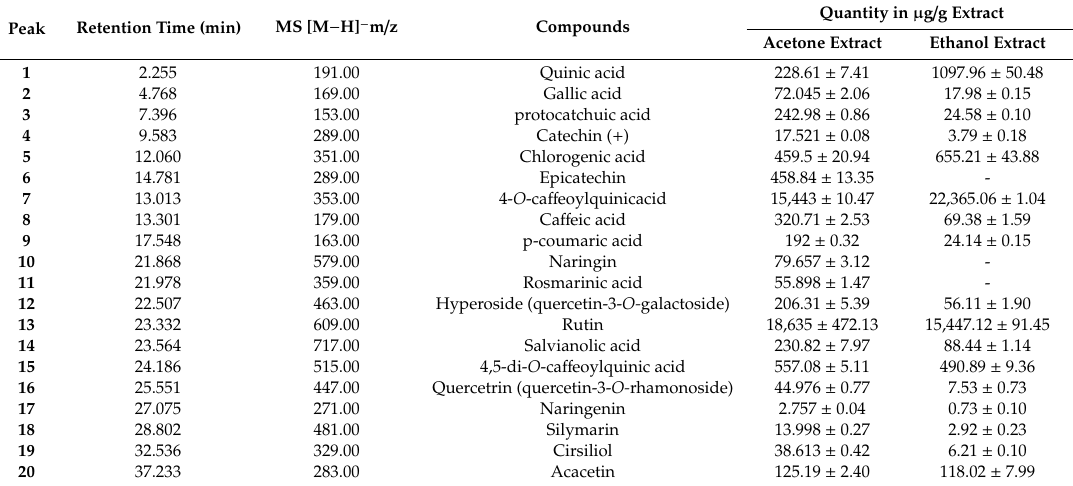
Table 2. Identified by HPLC-MS analysis of acetone and ethanol extract obtained from Oudneya Africana